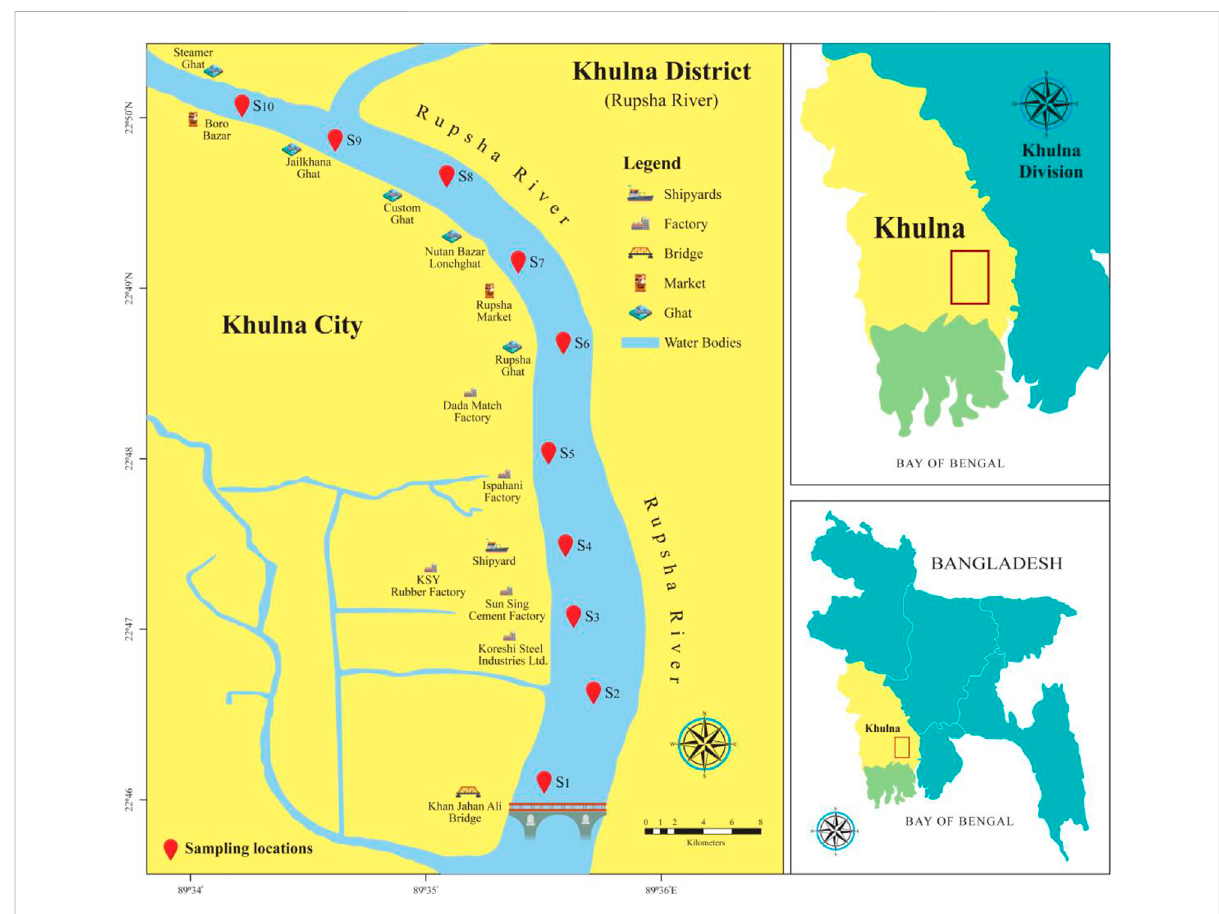
FIGURE 1 Map of the study area indicates the Rupsha River located south-western part of